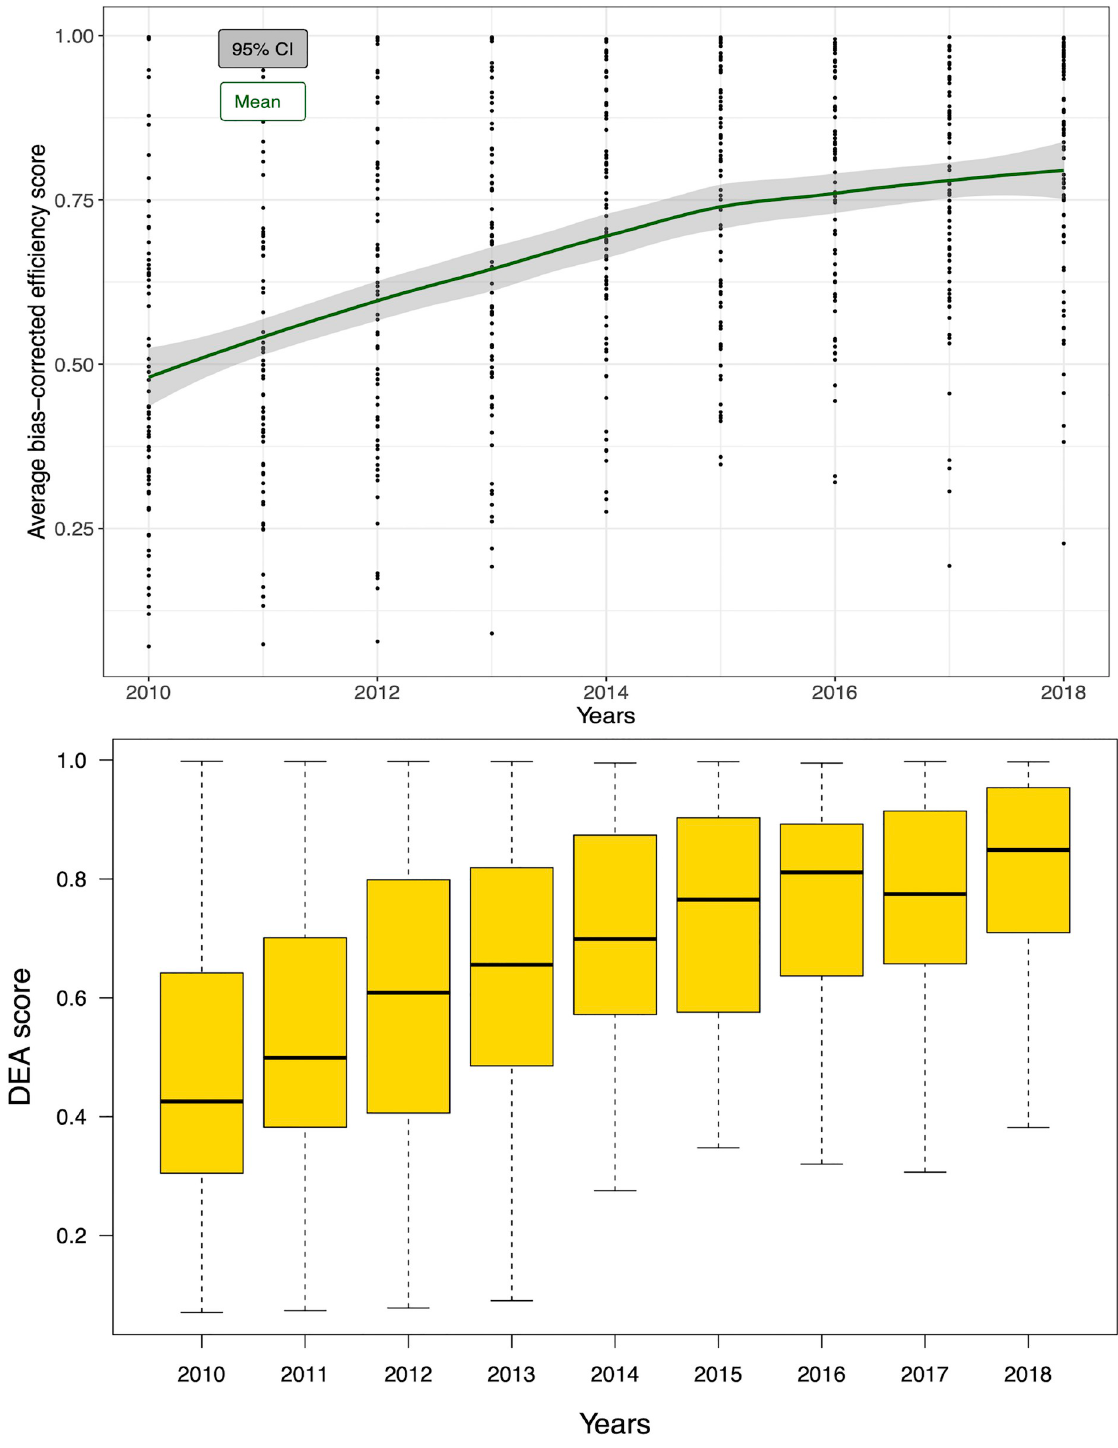
Fig 3. Mean and 95% CI of our adjusted technical efficiency scores over the years. Notes : black dots stand represent observations per year. Bottom figure presents the robust reciprocal of bias-corrected efficiency scores. Horizontal lines represent median values, boxes show the IQR, whiskers show data points within 1.5x|IQR|. DEA scores stand for efficiency scores.